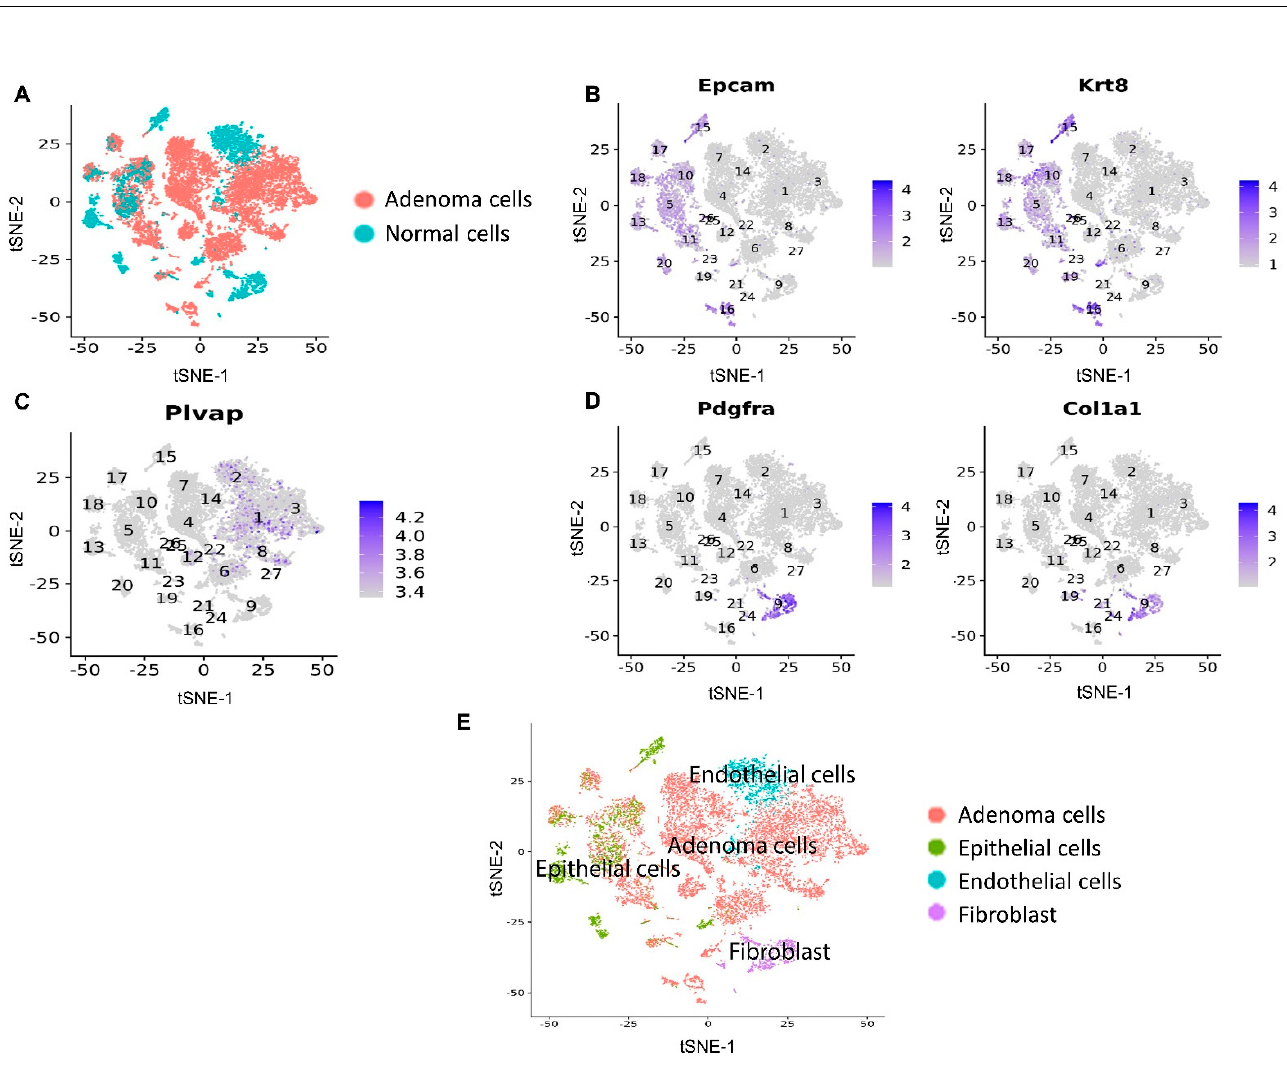
Figure 8. Clustering analysis based on scRNA-seq data from the CD45 − marker flow-sorted mouse lung samples of control and combined treatment groups. ( A ) Lung adenoma cells were identified based on the cell malignancy estimation. Marker gene expression for ( B ) epithelial cells, ( C ) endothelial cells, and ( D ) fibroblasts. ( E ) Annotation of the CD45 − cells into the four identified cell populations.